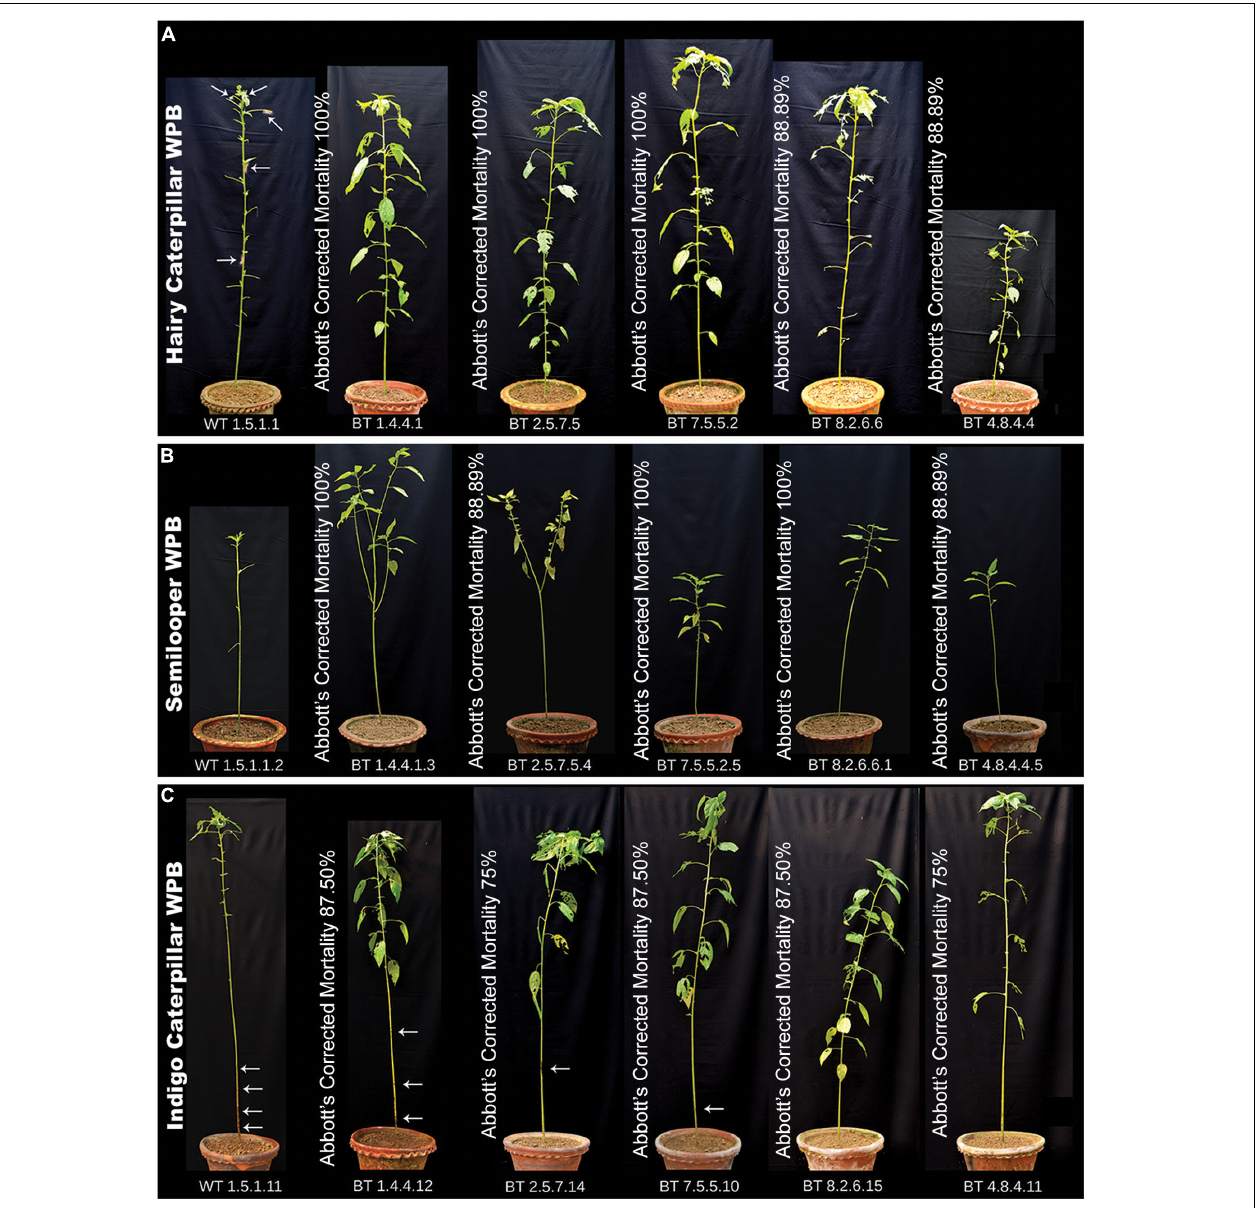
FIGURE 7 | Bt plants showing resistance to HC, SL and IC infestation in WPB. Each plant bio-assayed with 10 second instar larvae. Photograph for comparison of Bt jute and non-transgenic plants (WT) was taken on final day of bioassay and represent with the Abbott’s corrected larval mortality percentage. All WT plants showing complete damage by insects whereas transgenic lines showing insect resistance. (A) Bioassay with HC. Arrows showing some living insect in WT plant. (B) Bioassay with SL and (C) Bioassay with IC. Arrows showing location of damage in stem by IC in WT and Bt jute